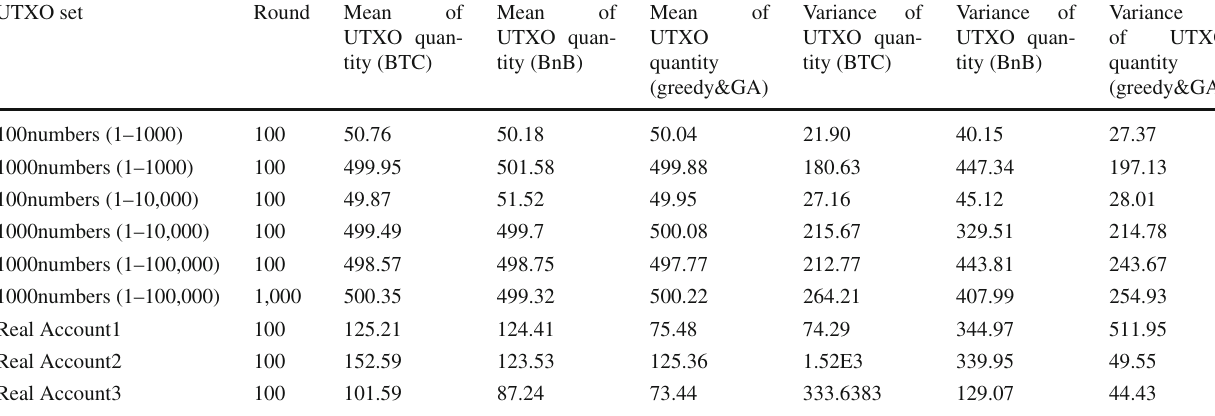
Table 2 Results from bitcoin transaction selection methods (UTXO quantity)